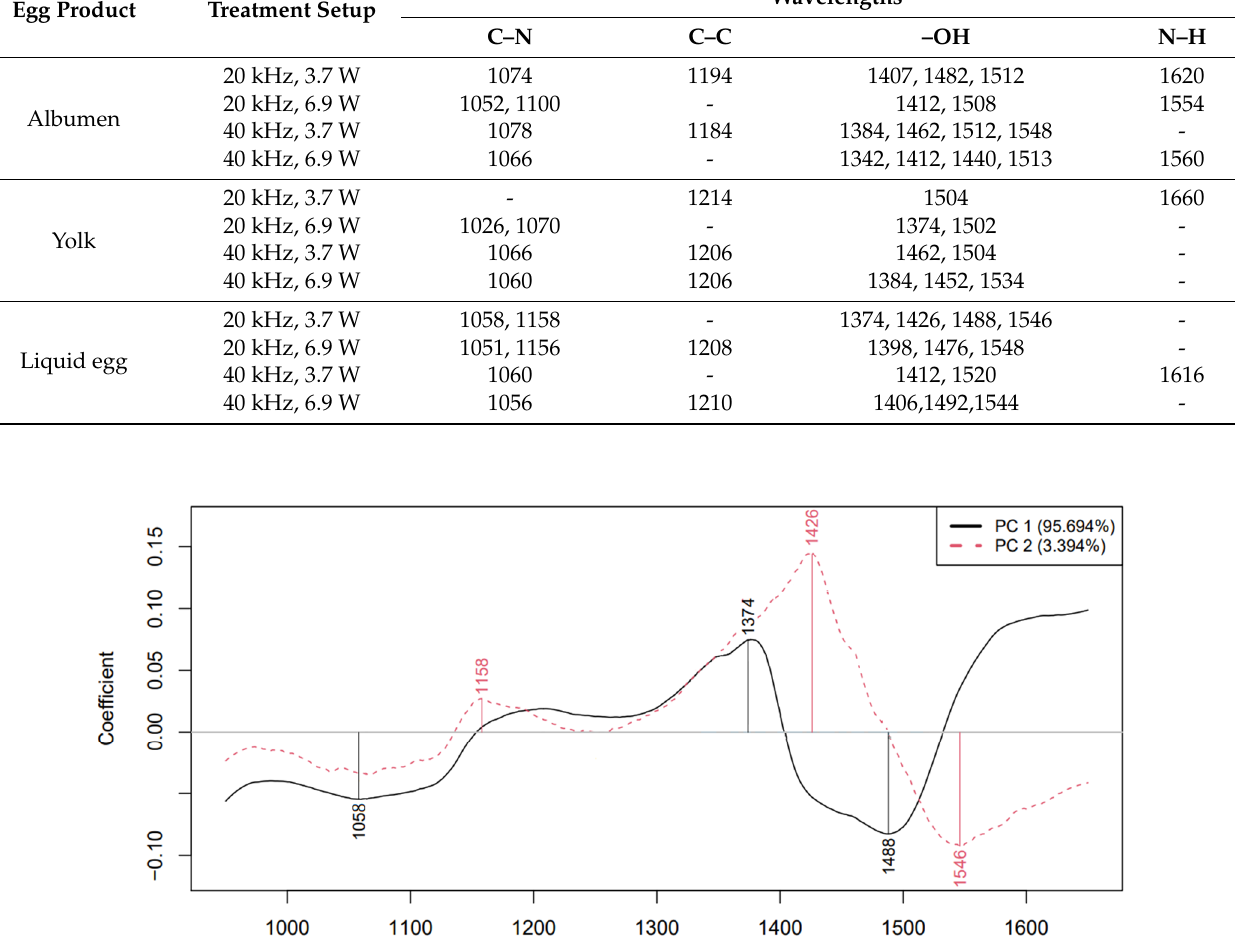
Table 2. The contributing wavelengths for principal component analysis (PCA) based on loading values. Egg Product